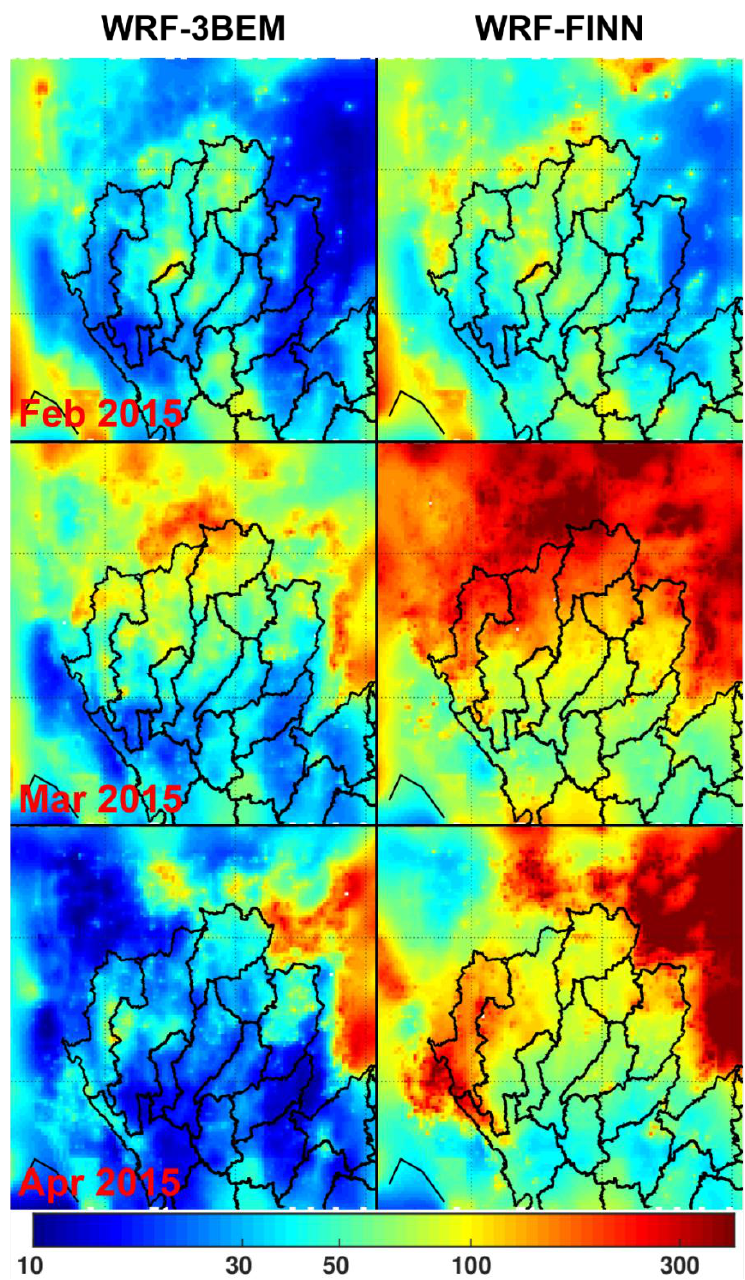
Figure 12. Comparisons of simulated monthly average PM10 concentrations ( µ g m − 3 ) at 2 m above ground of WRF-3BEM and WRF-FINN. Top to bottom are February, March, and April of 2015.